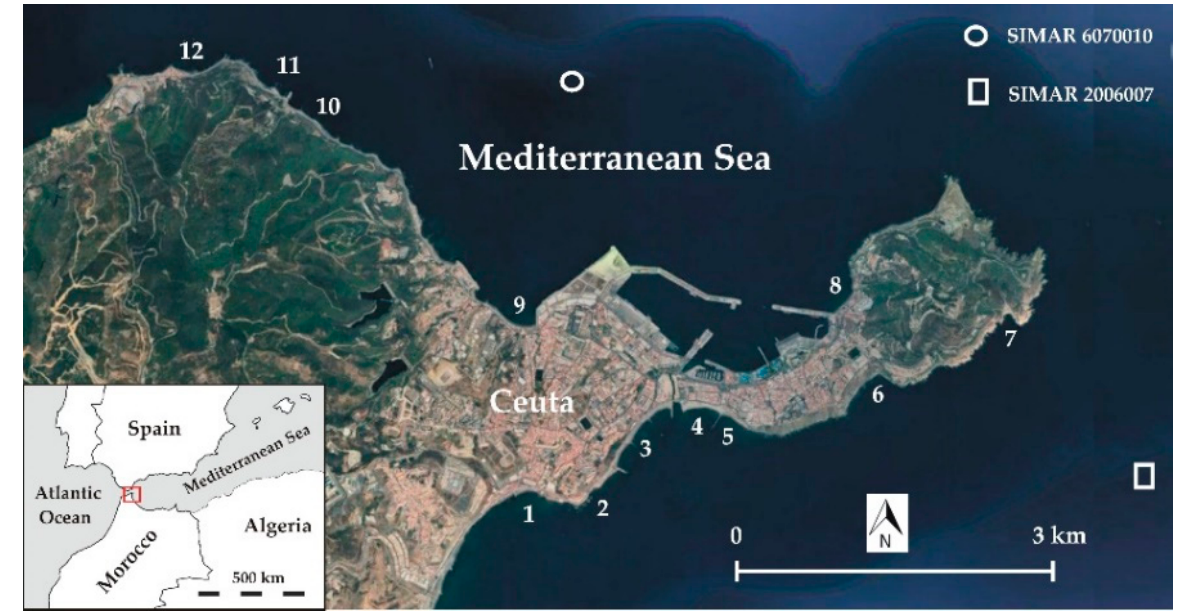
Figure 1. Location map of the beaches investigated and “SIMAR” wave points.